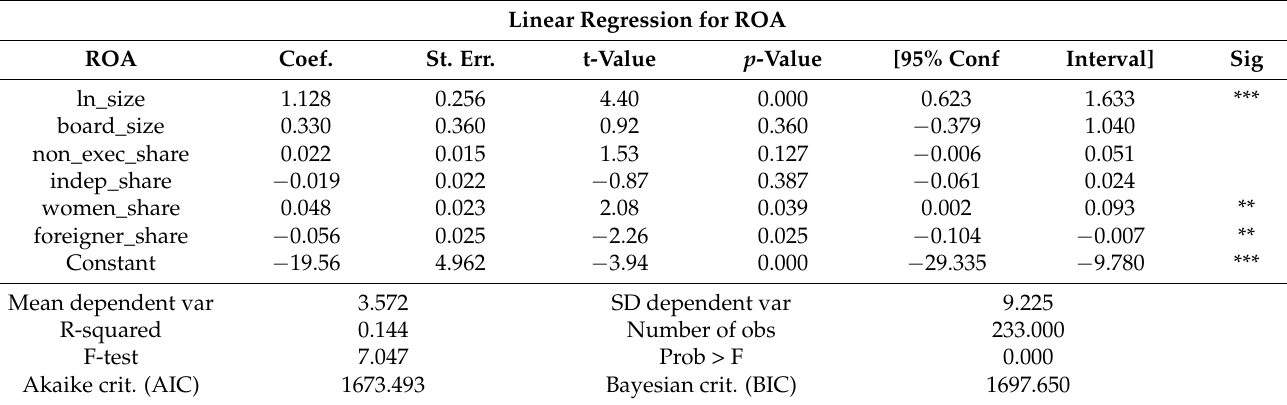
Table 4. OLS regression results with the board diversity measures. Linear Regression for